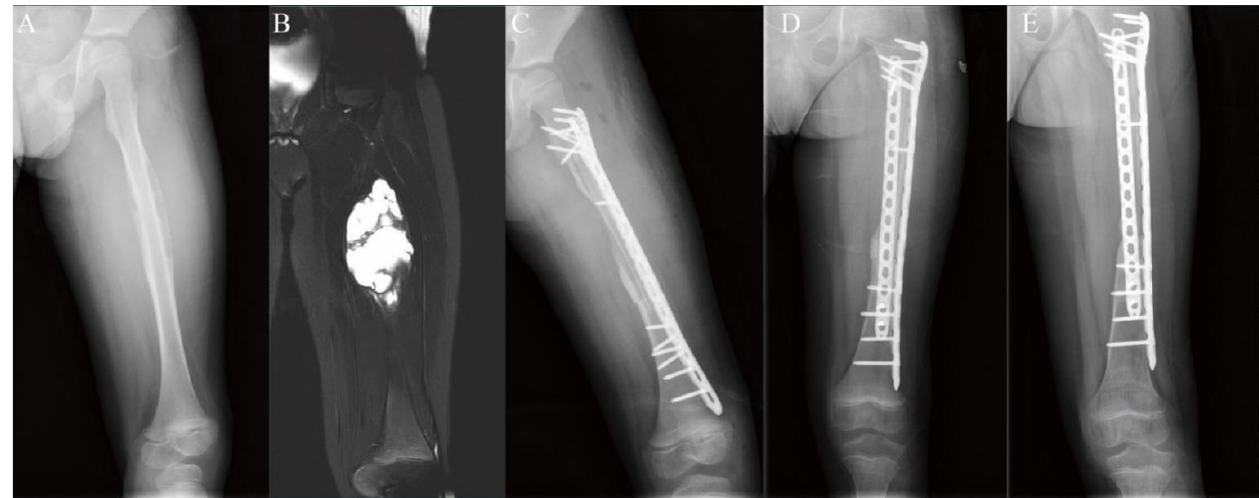
Figure 5. Diaphyseal reconstruction of the left femur. ( A , B ) A male patient, aged 8 years, was histologically diagnosed with Ewing’s sarcoma. The tumor was assessed by both radiograph and magnetic resonance imaging. ( C ) Photograph illustrating reconstruction with the fibular graft inserted into the medullary canal of the autograft and fixation with a single plate. ( D ) Photograph showing the replacement of the broken steel plate with double plates two months after surgery. ( E ) Radiograph showing primary union eight months after surgery.